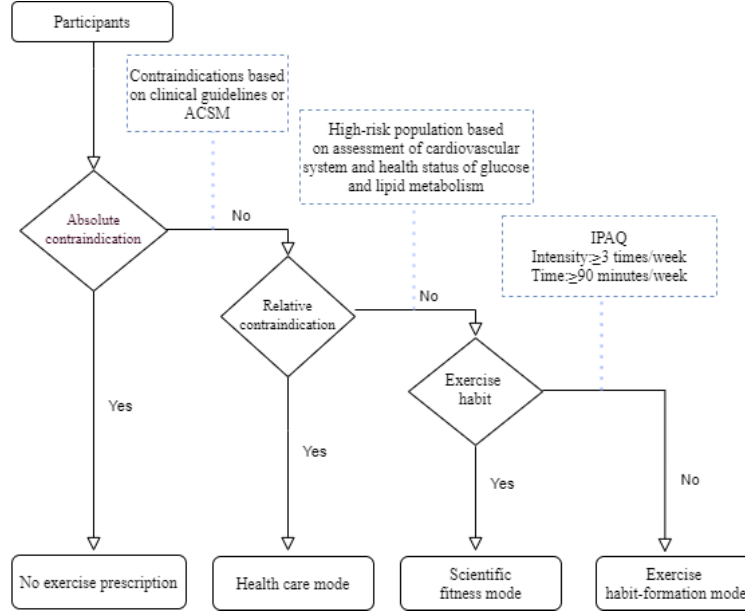
Figure 4. Algorithms for 3 modes of exercise prescription. ACSM: The American College of Sports Medicine. IPAQ: International Physical Activity